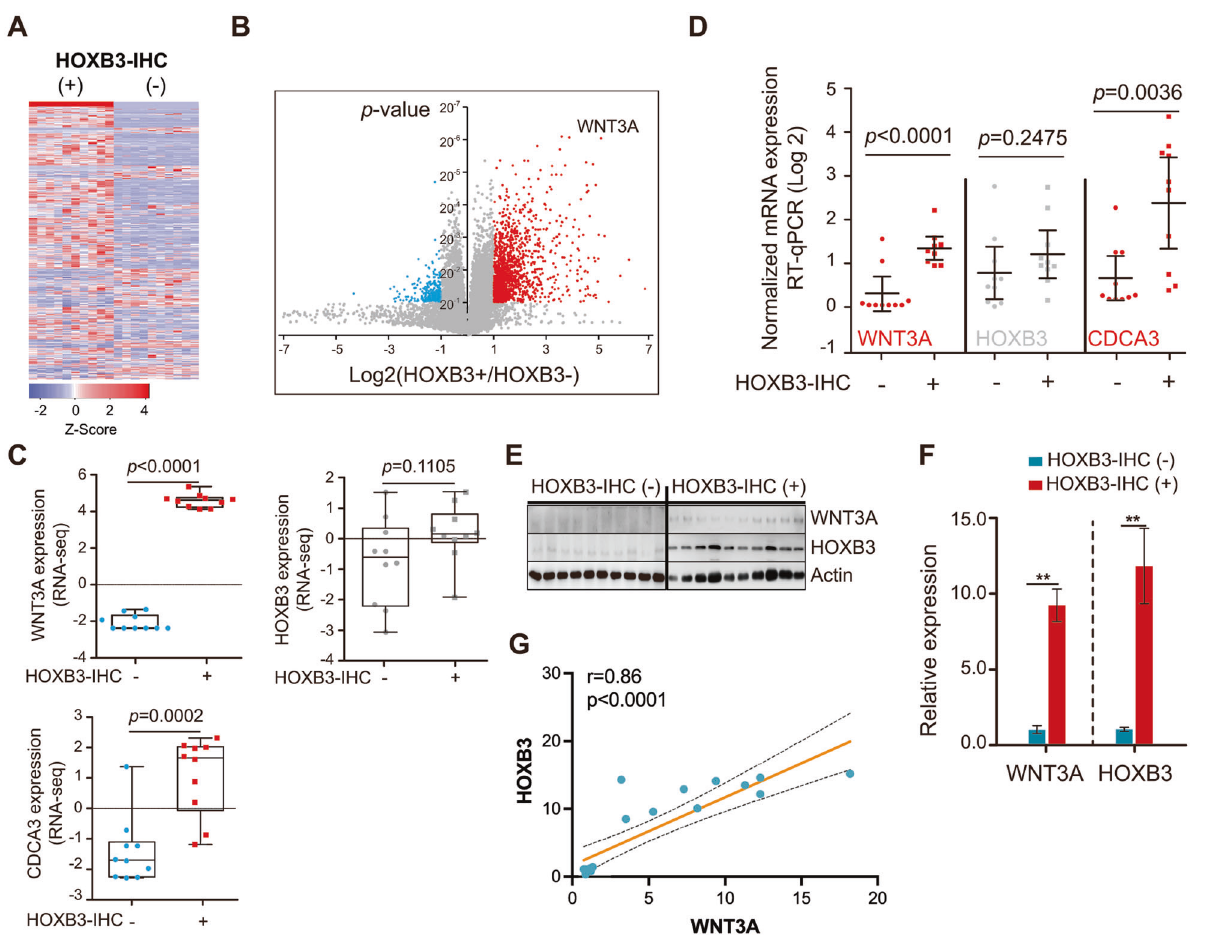
Fig. 3 HOXB3 protein, but not mRNA, correlates with WNT3A Expression in PCA. A Heatmap showing differentially expressed genes in aPCA with negative (HOXB3 − , n = 10) and high score (HOXB3 + , n = 10) of HOXB3 determined by RNA-Seq (see also Table S2). B Volume plot showing the signi fi cantly different expression of WNT3A between HOXB3 + and HOXB3 − tumors determined by RNA-Seq (see also Table S2). C Scatter plots with bar showing individual expression of WNT3A, HOXB3, and CDCA3 (target gene of HOXB3) in both HOXB3- and HOXB3 + groups determined by RNA-Seq (see also Table S2). D qRT-PCR measured WNT3A, HOXB3, and CDCA3 mRNA expression in both HOXB3 − and HOXB3 + groups ( n = 10 for each group). E Western blot of WNT3A, HOXB3, and CDCA3 protein expression in both HOXB3- and HOXB3 + groups ( n = 10 for each group). Error bars indicate mean ± SD. F Quanti fi ed results of the WNT3A and HOXB3 protein expression by Image J. G The signi fi cant correlation between WNT3A and HOXB3 protein expression in Fig. 3E should be determined by Pearson Correlation Coef fi